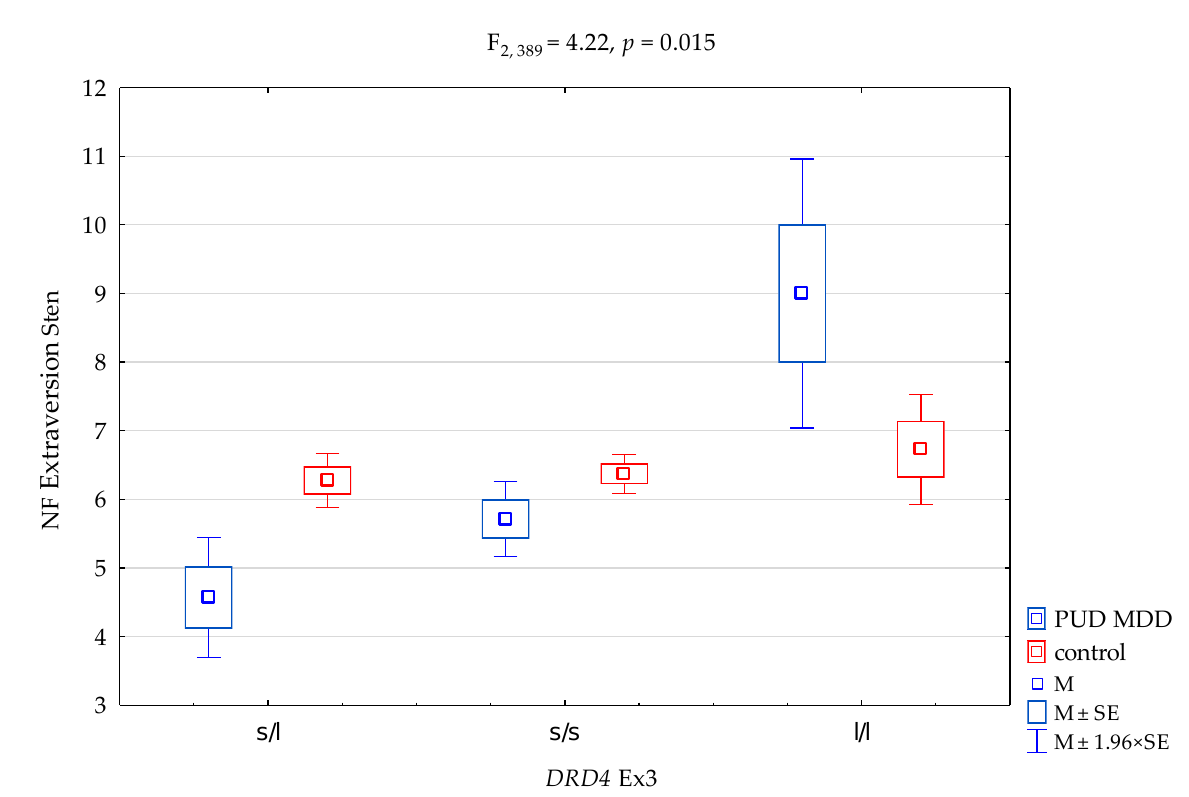
Figure 1. Interaction between patients with polysubstance use disorder comorbid with a depressive episode (PUD MDD)/control and DRD4 exon 3 ( DRD4 Ex3) and the NEO FFI Extraversion Scale. M, mean; SE, standard error. Table 7. Post hoc analysis of interactions between patients with polysubstance use disorder comorbid with a depressive episode (PUD MDD)/control and DRD4 exon 3 ( DRD4 Ex3) and the NEO FFI Extraversion/Conscientiousness